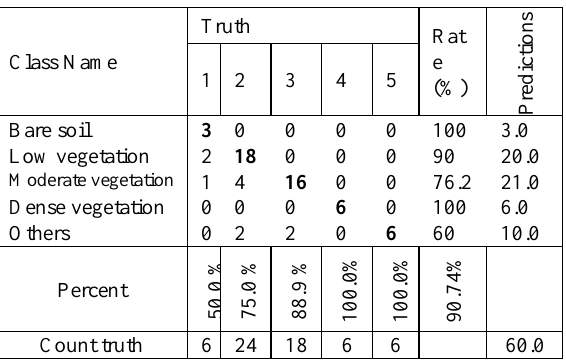
Table 2a. The results of accuracy assessment (Note: Since the